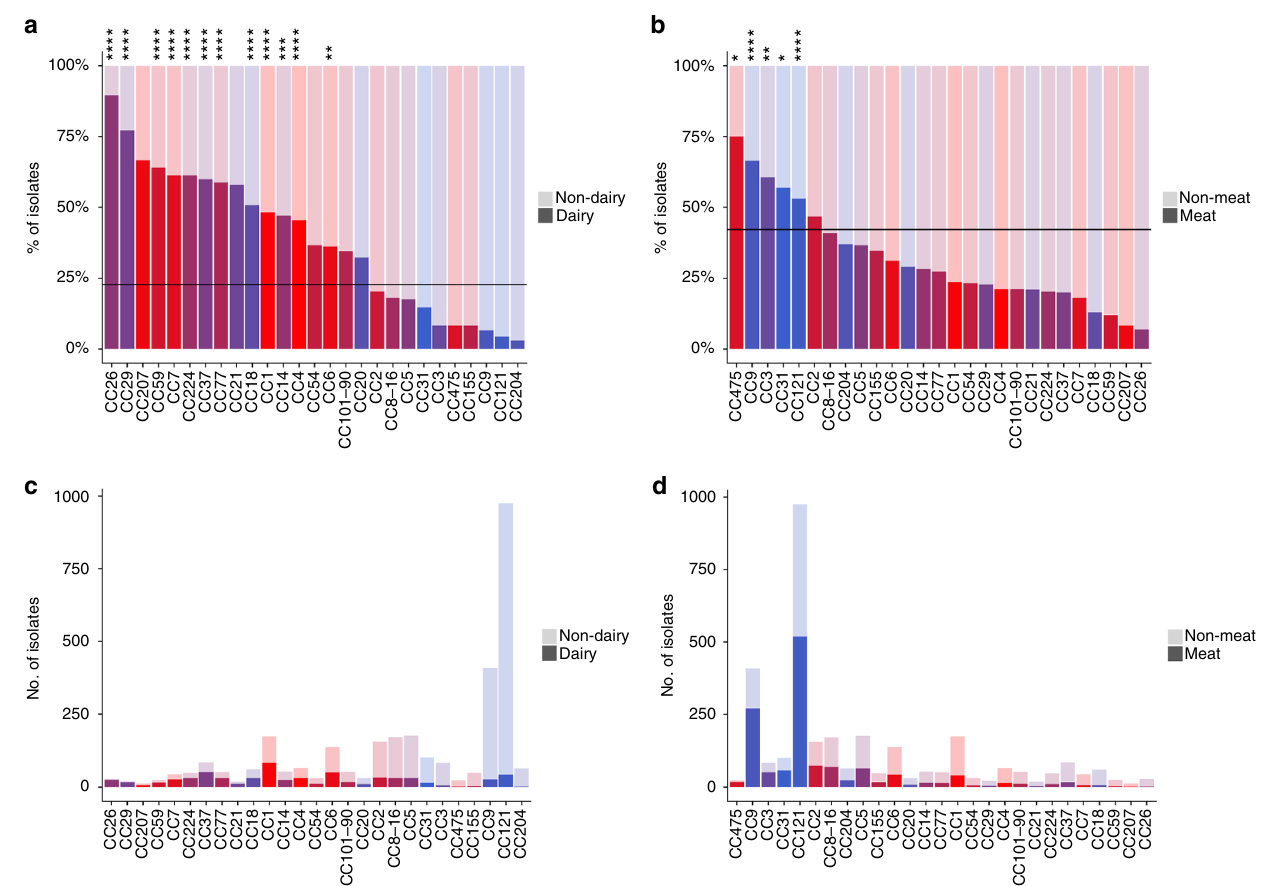
Fig. 2 Distribution of Lm CCs in food categories. Percentages and numbers of isolates from dairy products and meat products per MLST clone are shown. Major CCs that represent individually at least 0.5% of all the isolates of the study are shown, representing in total 94.1% of all isolates. a Proportions of dairy (dark colors)/non-dairy (light colors) isolates per CC. Non-dairy isolates were those isolated from meat products, seafood products, fruits and vegetables, mixed products, and unknown products. Clones are sorted per percentage of isolates from dairy products. b Proportions of meat (dark colors)/ non-meat (light colors) isolates per CC. Non-meat isolates were those isolated from dairy products, seafood products, fruits and vegetables, mixed products, and unknown products. Clones are sorted per percentage of isolates from meat products. a , b Horizontal lines represent the mean percentage of dairy products in a and meat products in b considering all food isolates together. Colors are as in Fig. 1a. Positive statistical associations ( χ 2 tests) of CCs with dairy or meat origins are shown. **** p < 1.10 − 5 ; *** p < 1.10 − 4 ; ** p < 1.10 − 3 ; * p < 0.05. Statistics for mixed products, fruits and vegetables and unknown sources are not provided. c Number of dairy (dark colors) / non-dairy (light colors) isolates per clone in the same ordering than in a . d Number of meat (dark colors)/non-meat (light colors) isolates per clone in the same ordering than in